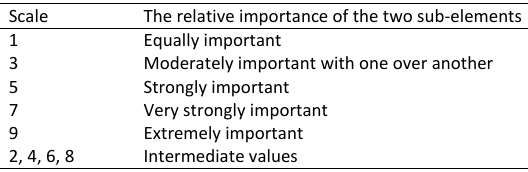
Table 1: Scale for pairwise comparison (Celik, 2018)